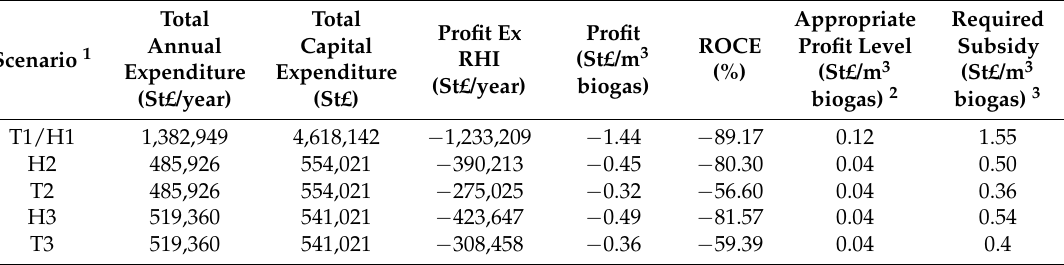
Table 9. Results of economic analysis.